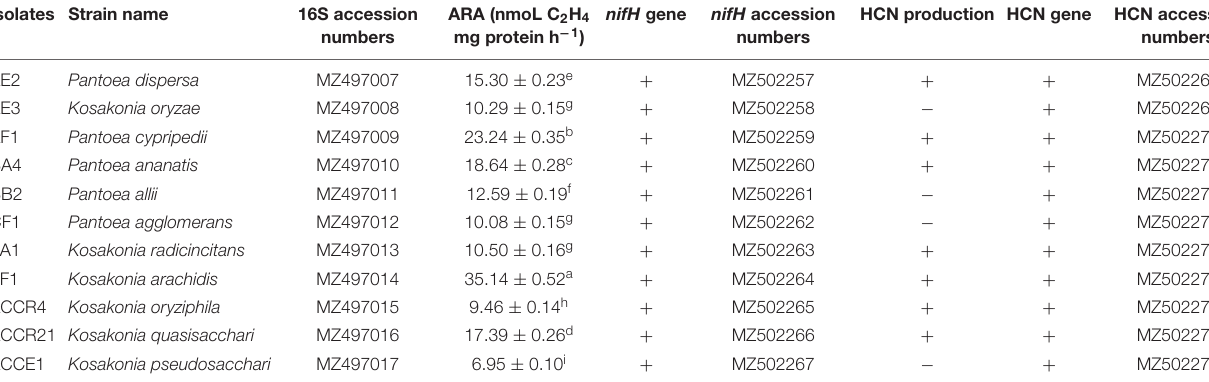
TABLE 1 | Identification of selected isolates through 16S rRNA gene and their nitrogenase activity via acetylene reduction assay, hydrogen cyanide production, and the presence of gene amplification with an accession number. Isolates Strain name